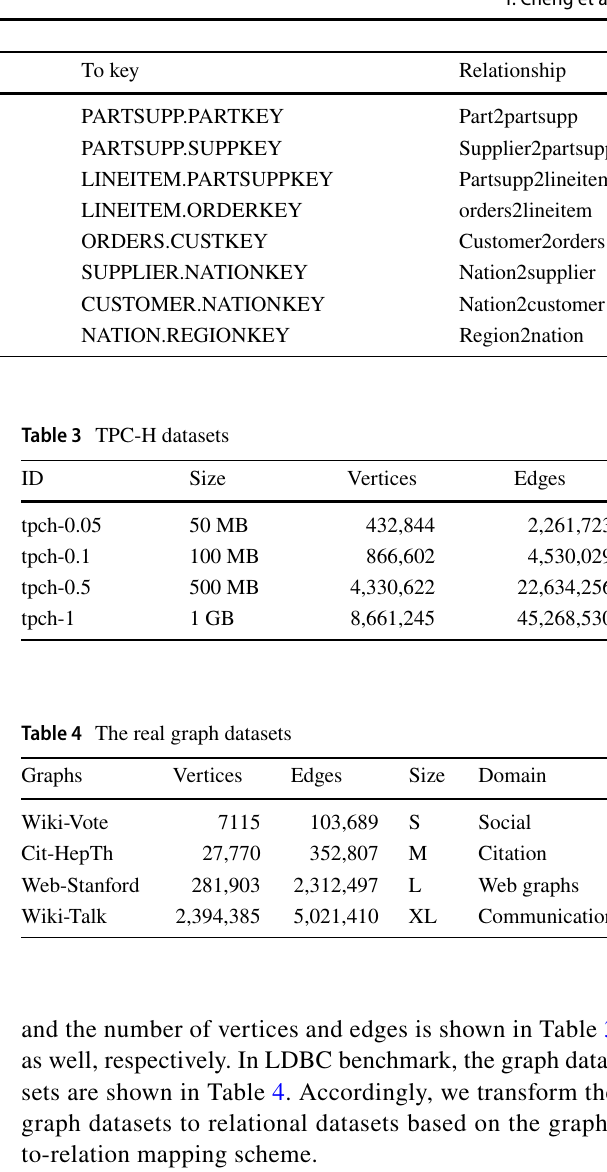
Table 2 Table key and relationship mapping